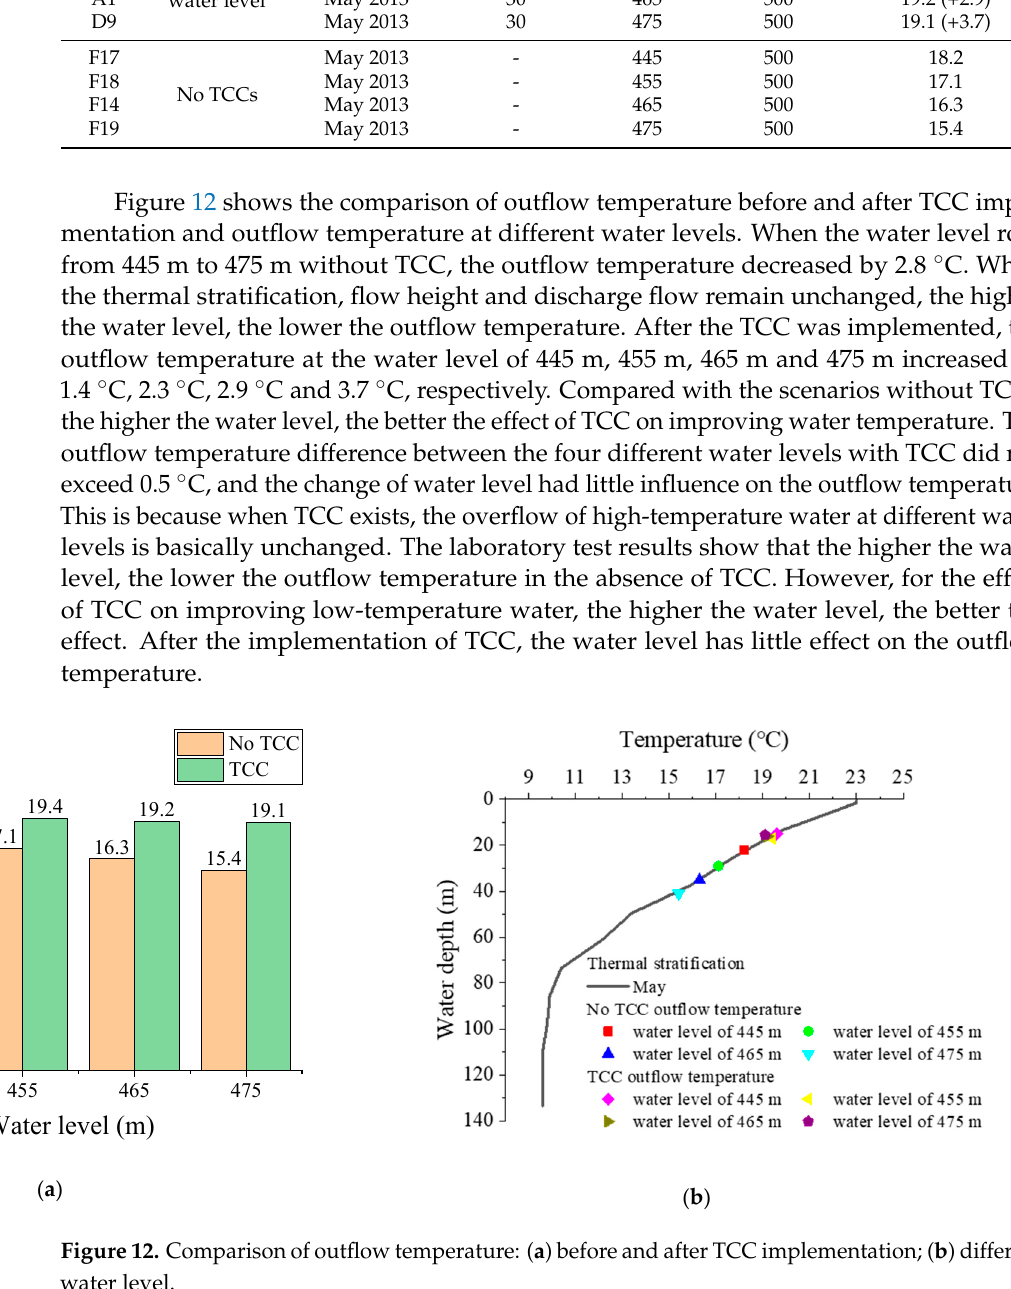
Table 7. Different water level test scenarios and results.